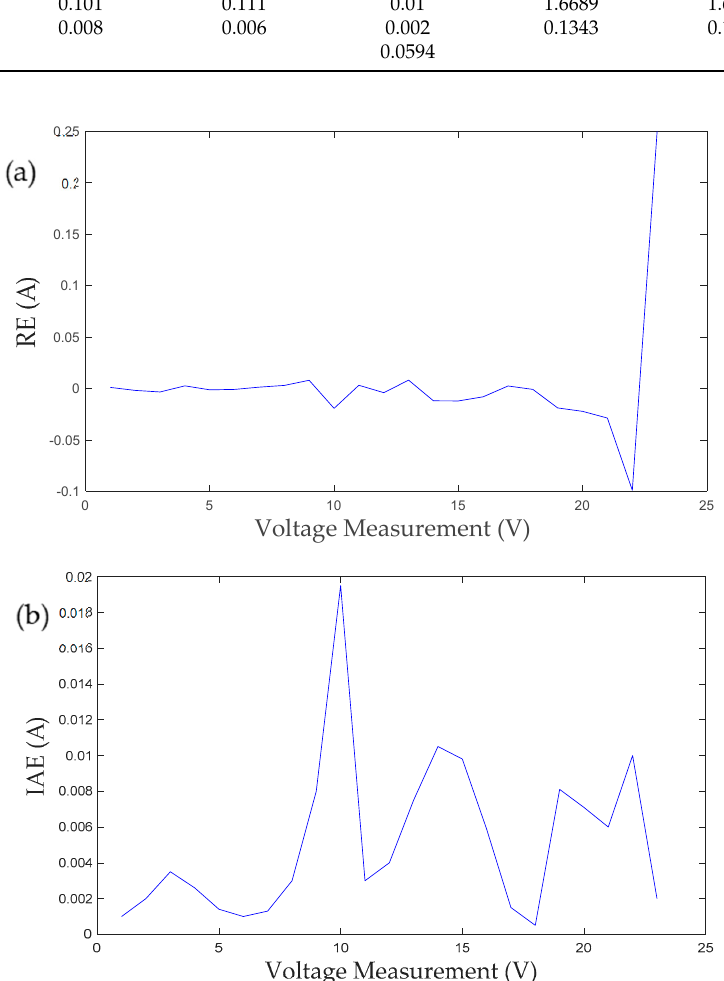
Table 3 represents the Internal absolute error (IAE) between the estimated and ex- perimental data sets. Every determined value of IAE (at 1000 W/m 2 and 30 °C) is less than 0.0195, which indicates that the parameters optimized by the TSA are very precise. The error relating to the measurement results for each of the 23 pair points is determined by the IAE and Relative Error (RE). The IAE and RE values are calculated using Equations (11) and (12). The curve of IAE and RE between experimental and estimated values is shown in Figure 4.